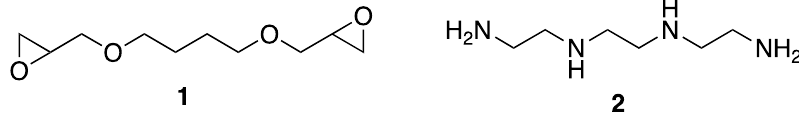
Figure 3. Molecular structures of 1,4-butanediol diglycidyl ether 1 and triethylenetetramine 2 .